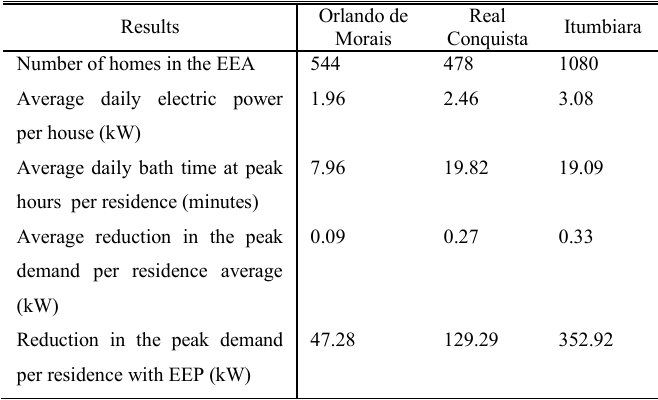
TABLE VI I NPUT D ATA FOR S